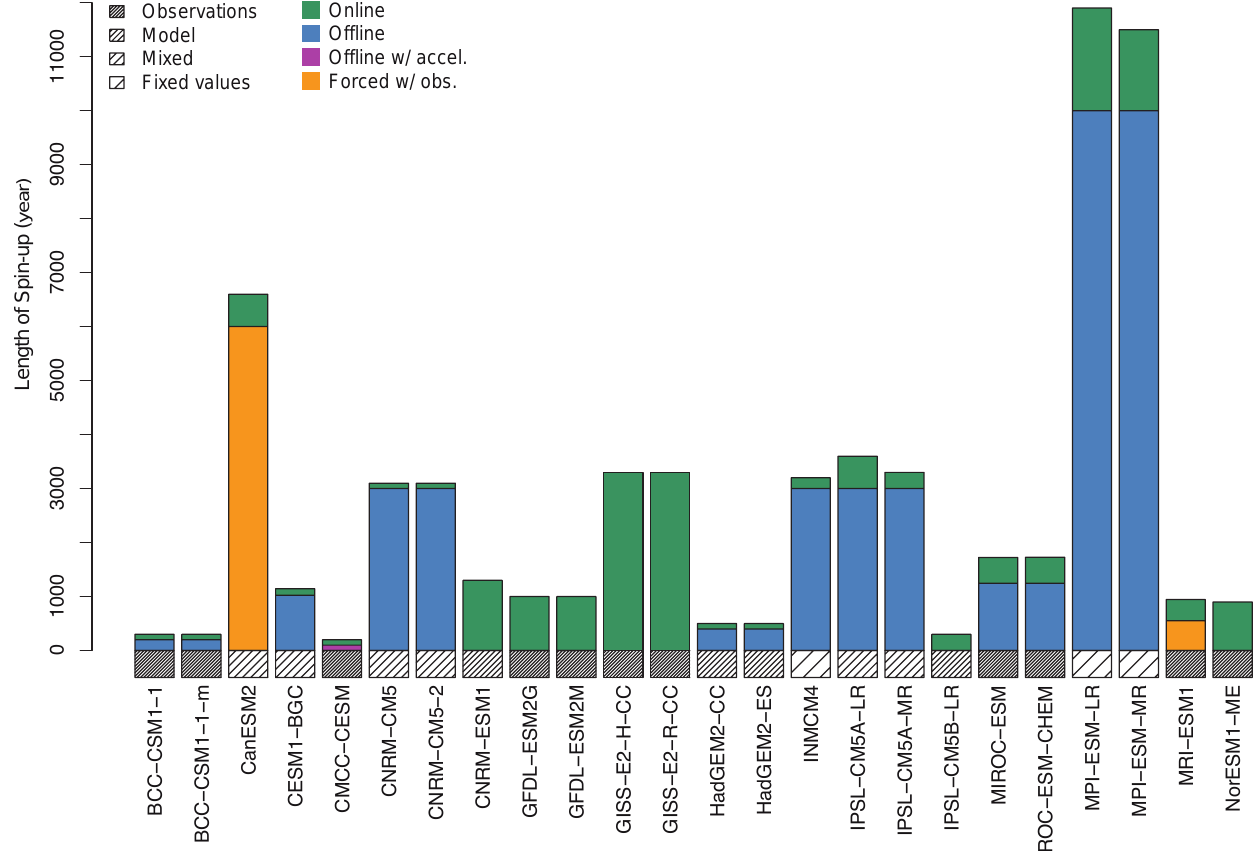
Figure 1. Spin-up protocols of CMIP5 Earth system models. Color shading represents strategies of the various modeling groups. Online and Offline steps refer to runs performed with coupled climate model and with stand-alone ocean biogeochemistry model, respectively. Sources of initial conditions for biogeochemical components of CMIP5 Earth system models are indicated as hatching below the